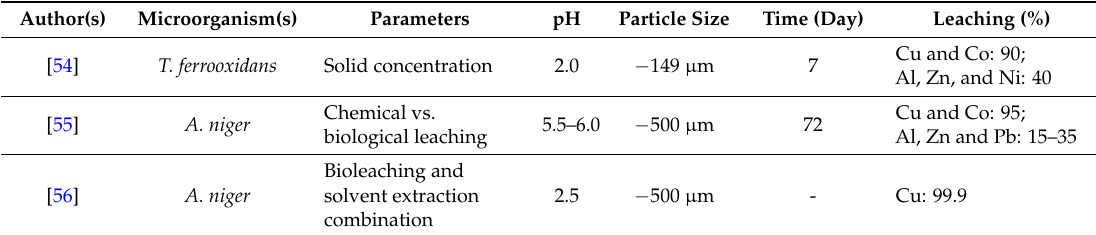
Table 3. Bioleaching research of electronic waste according to the parameters studied and recoveries achieved as well as microorganisms used in the studies. The articles appear in chronological